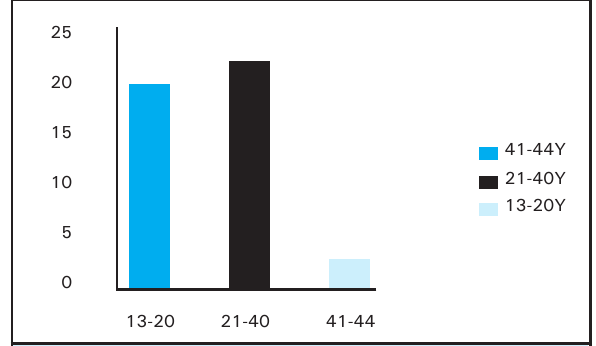
Figure 1. Age Distribution of Patients. There were 18 (40%) female patients and 27 (60%) male patients. Male: Female ratio was 1.5:1.